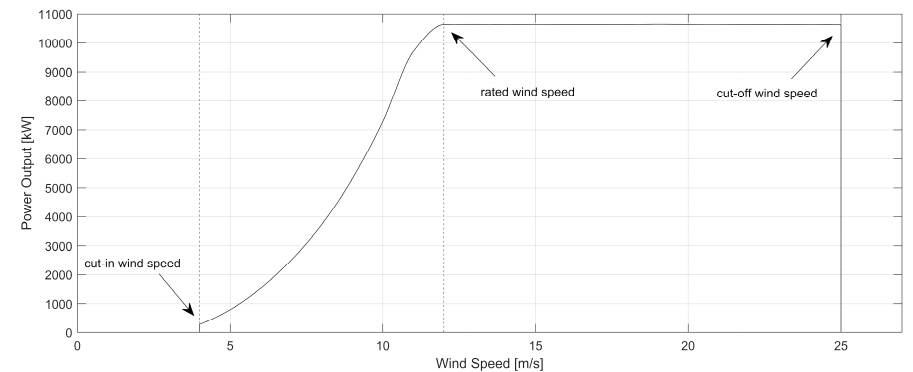
Figure 2. Power curve and power coe ffi cient of the 10.6 MW reference wind turbine.